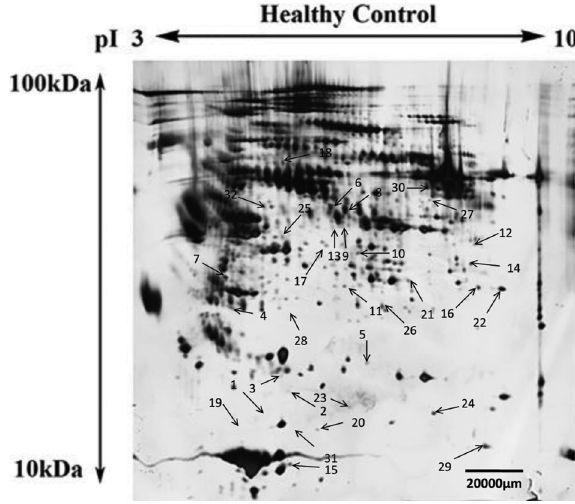
Figure 1. Representative image of a two-dimensional electro- phoresis silver stained gel of depleted plasma sampled from healthy control subjects. Thirty-two differentially expressed protein spots (numbered with arrows) were identi fi ed across various bipolar disorder (BD) mood states (depressed BD, manic BD, and euthymic BD) relative to healthy controls.